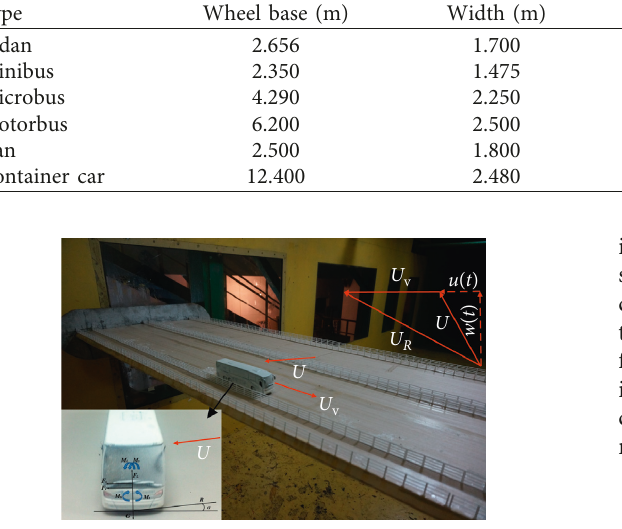
Figure 8: Mechanical model of the vehicle-bridge